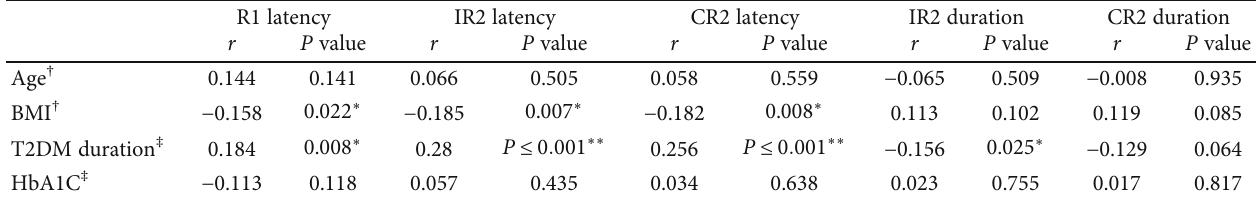
Table 3: Correlation analysis of blink re fl ex with age, BMI, duration of T2DM, and HbA1C.